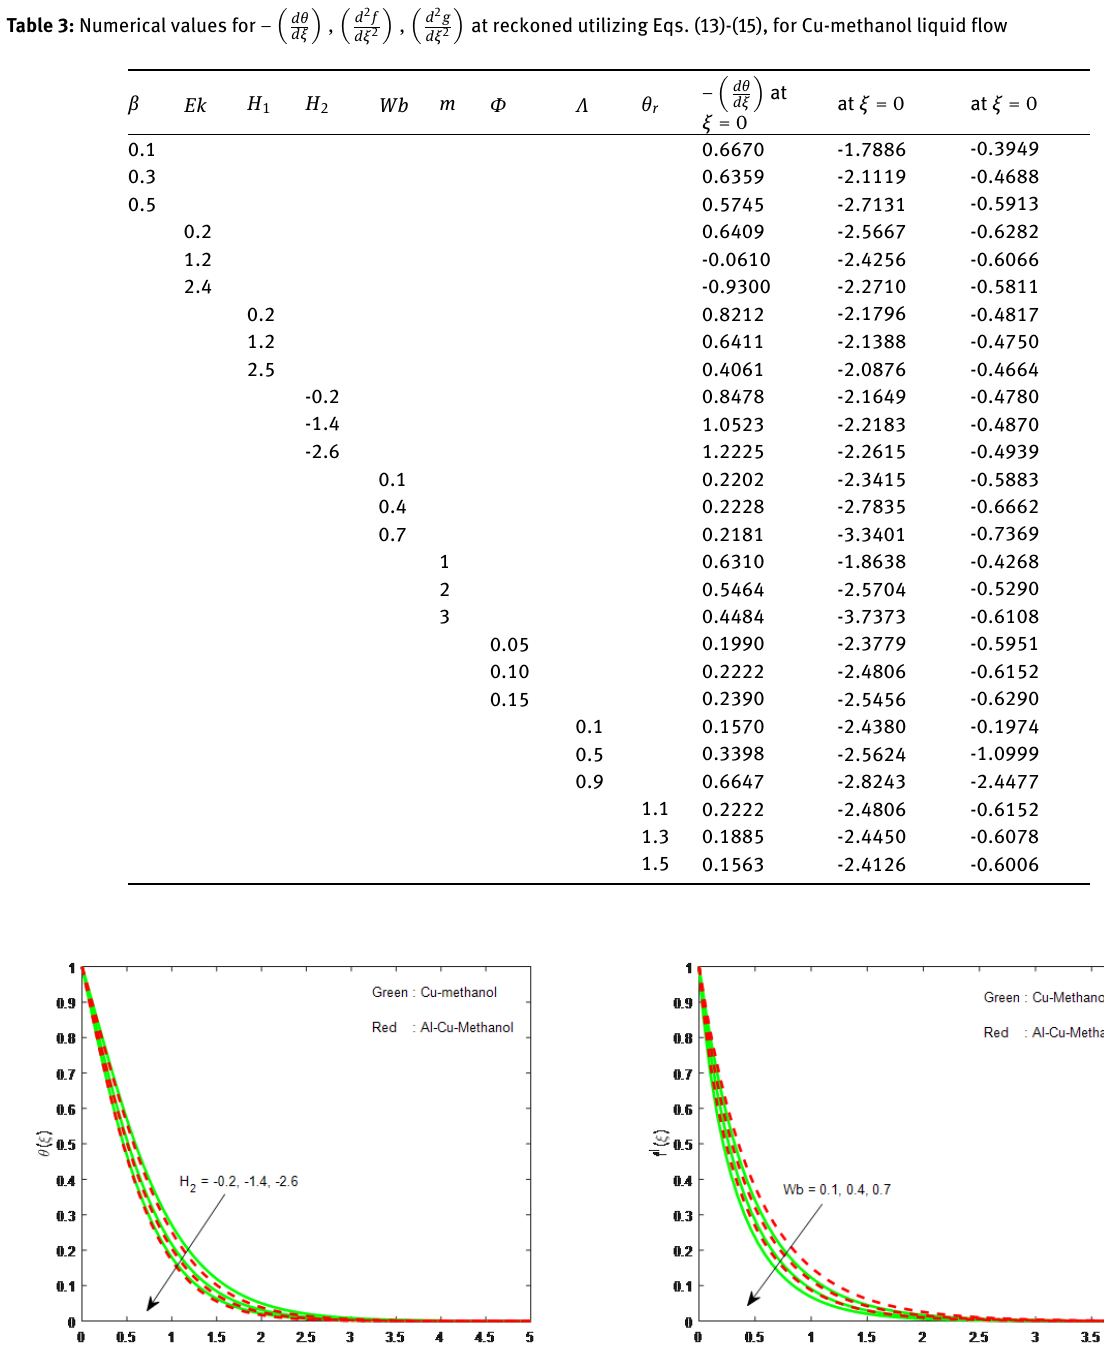
Table 3: Numerical values for −